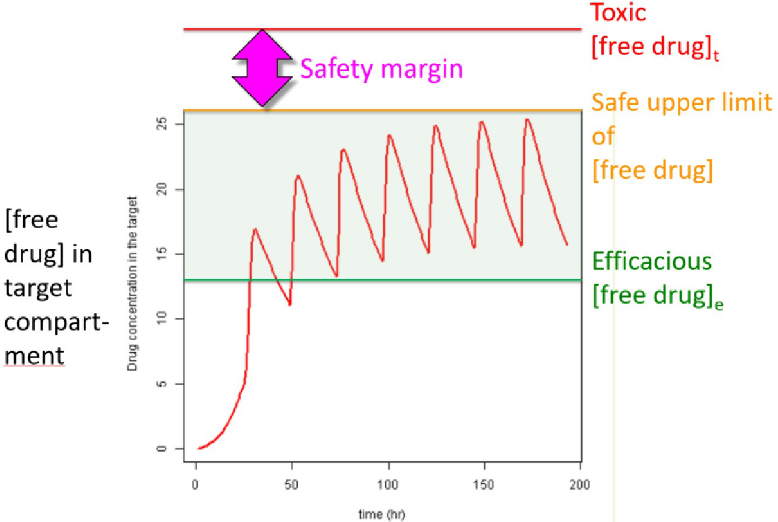
Fig 15. Hypothetical plot of drug L versus time (red), showing a series of buildup-decay cycles (one per dose) culminating in a steady-state condition, together with the efficacious threshold of L (green), the safe upper limit of L (orange), and the toxic level of L (red). L is maintained in the efficacious/sub-toxic “green zone” by overshooting and decaying back to the efficacious level. Optimizing to the SSO regime affords the greatest chance of achieving a therapeutic index in